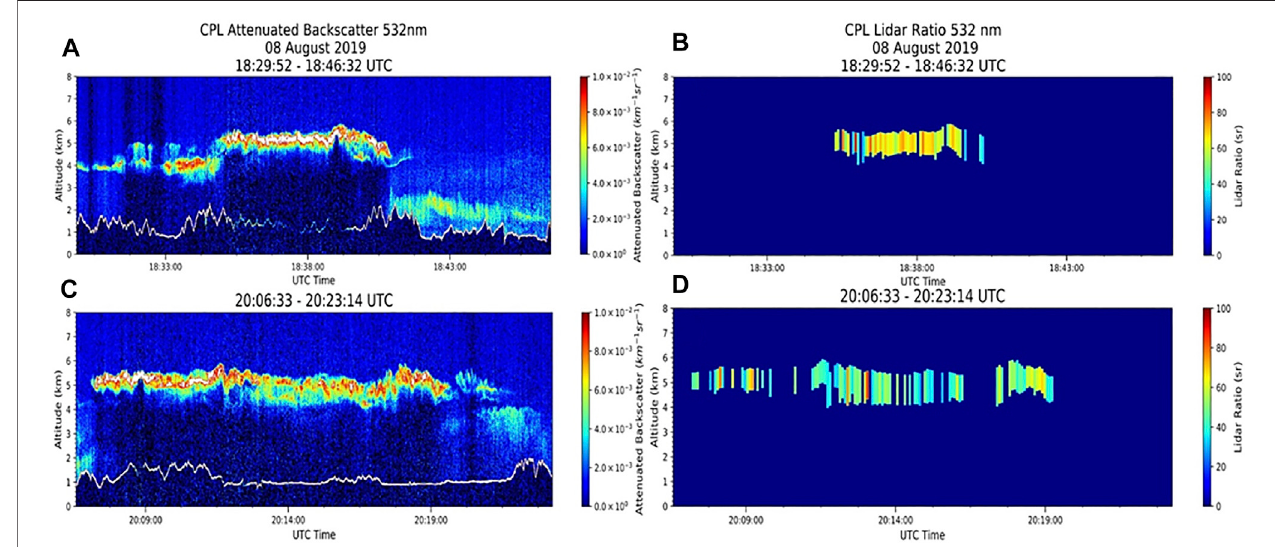
FIGURE 2 | CPL 532 nm attenuated backscatter curtain plots (A,C) for the 18:29:52 – 18:46:32 UTC (top) and 20:06:33 – 20:23:14 UTC (bottom) smoke plumes sampled during an overpass of the Williams Flats Fire on 8 August 2019 and the corresponding signal loss calculated lidar ratio values curtain plots (B,D) .